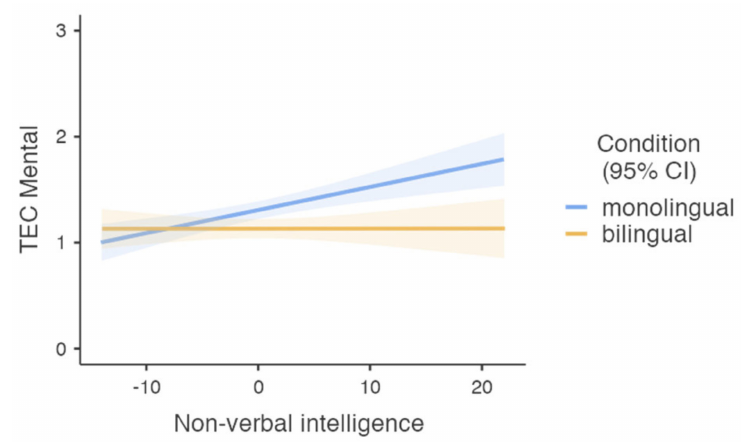
Figure 1. Ability to understand mental causes of emotions in monolingual ( n = 319) and bilingual ( n = 277) children with different levels of non-verbal fluid intelligence. Colored shades represent the confidence intervals. Note: non-verbal intelligence scores presented as Z scores.